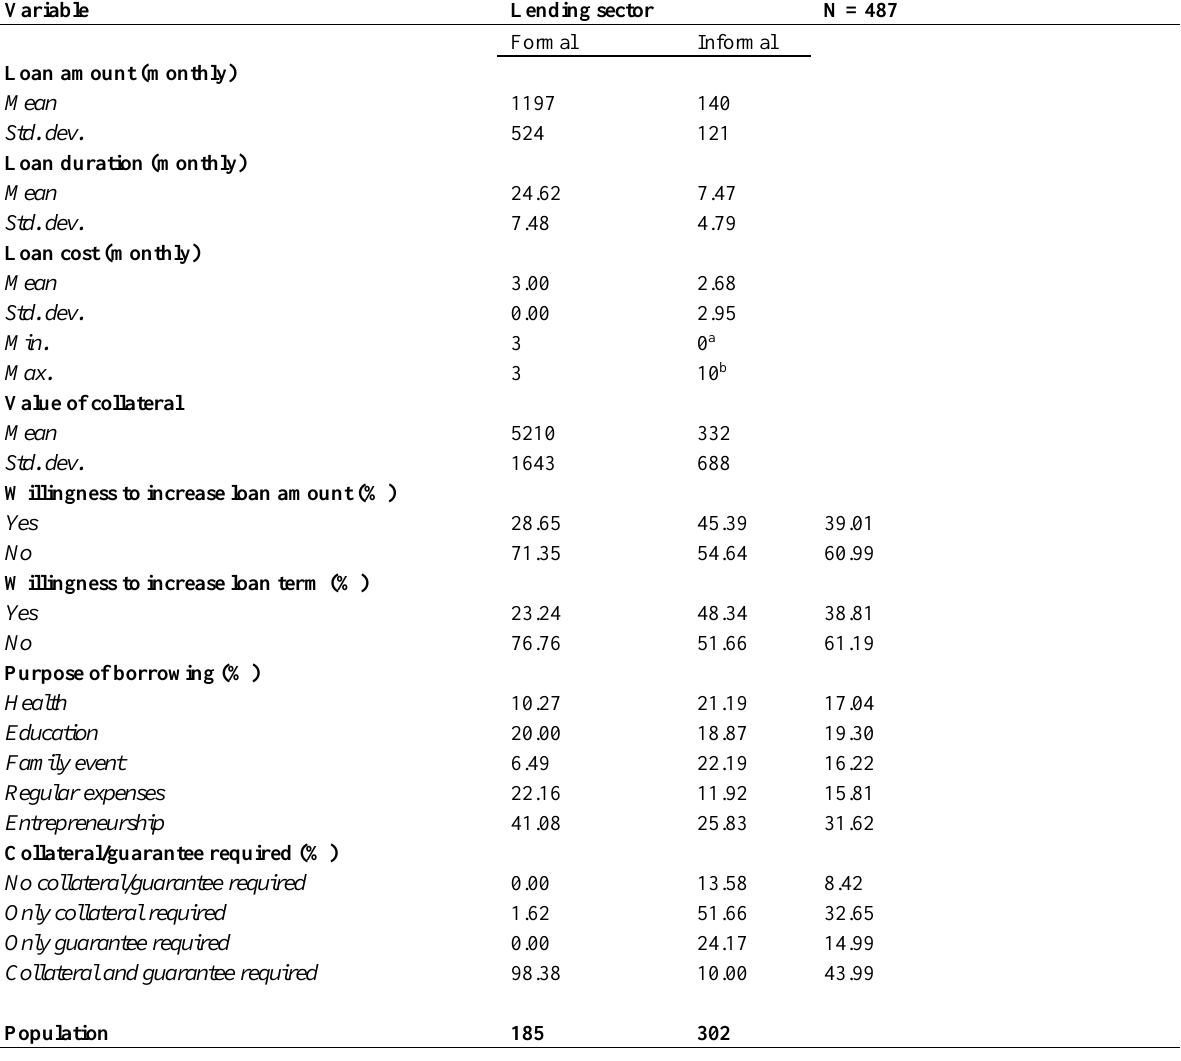
Table 3: Summary of loan characteristics by lending